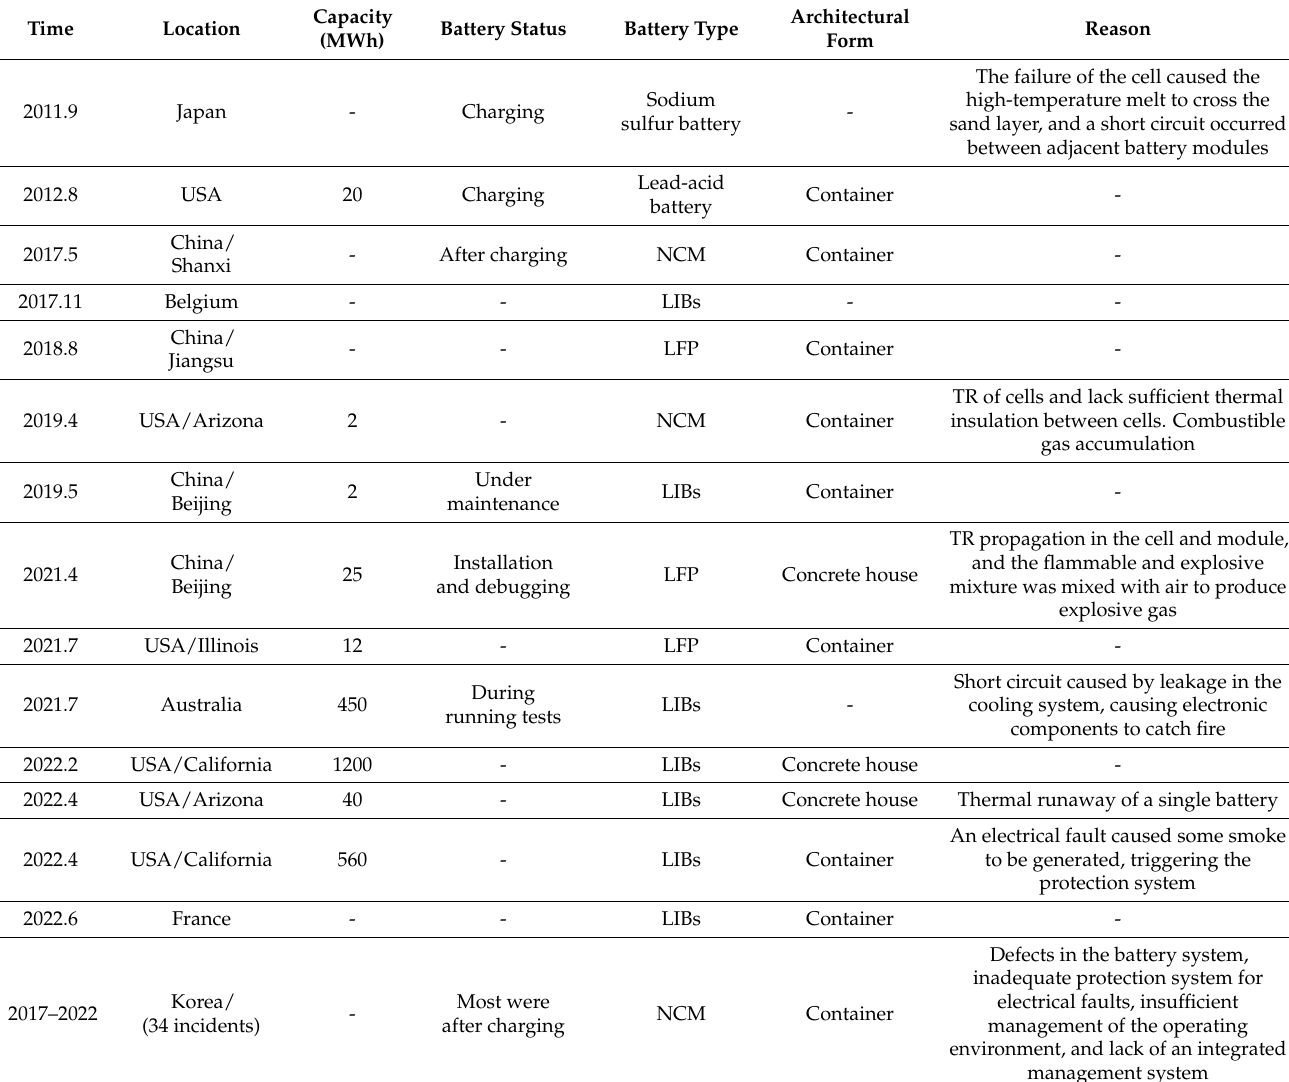
Table 7. Statistics on fire accidents involving energy storage power stations in the past 10